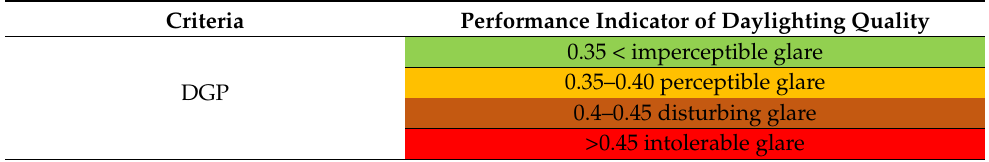
Table 3. The performance indicator of daylight glare probability